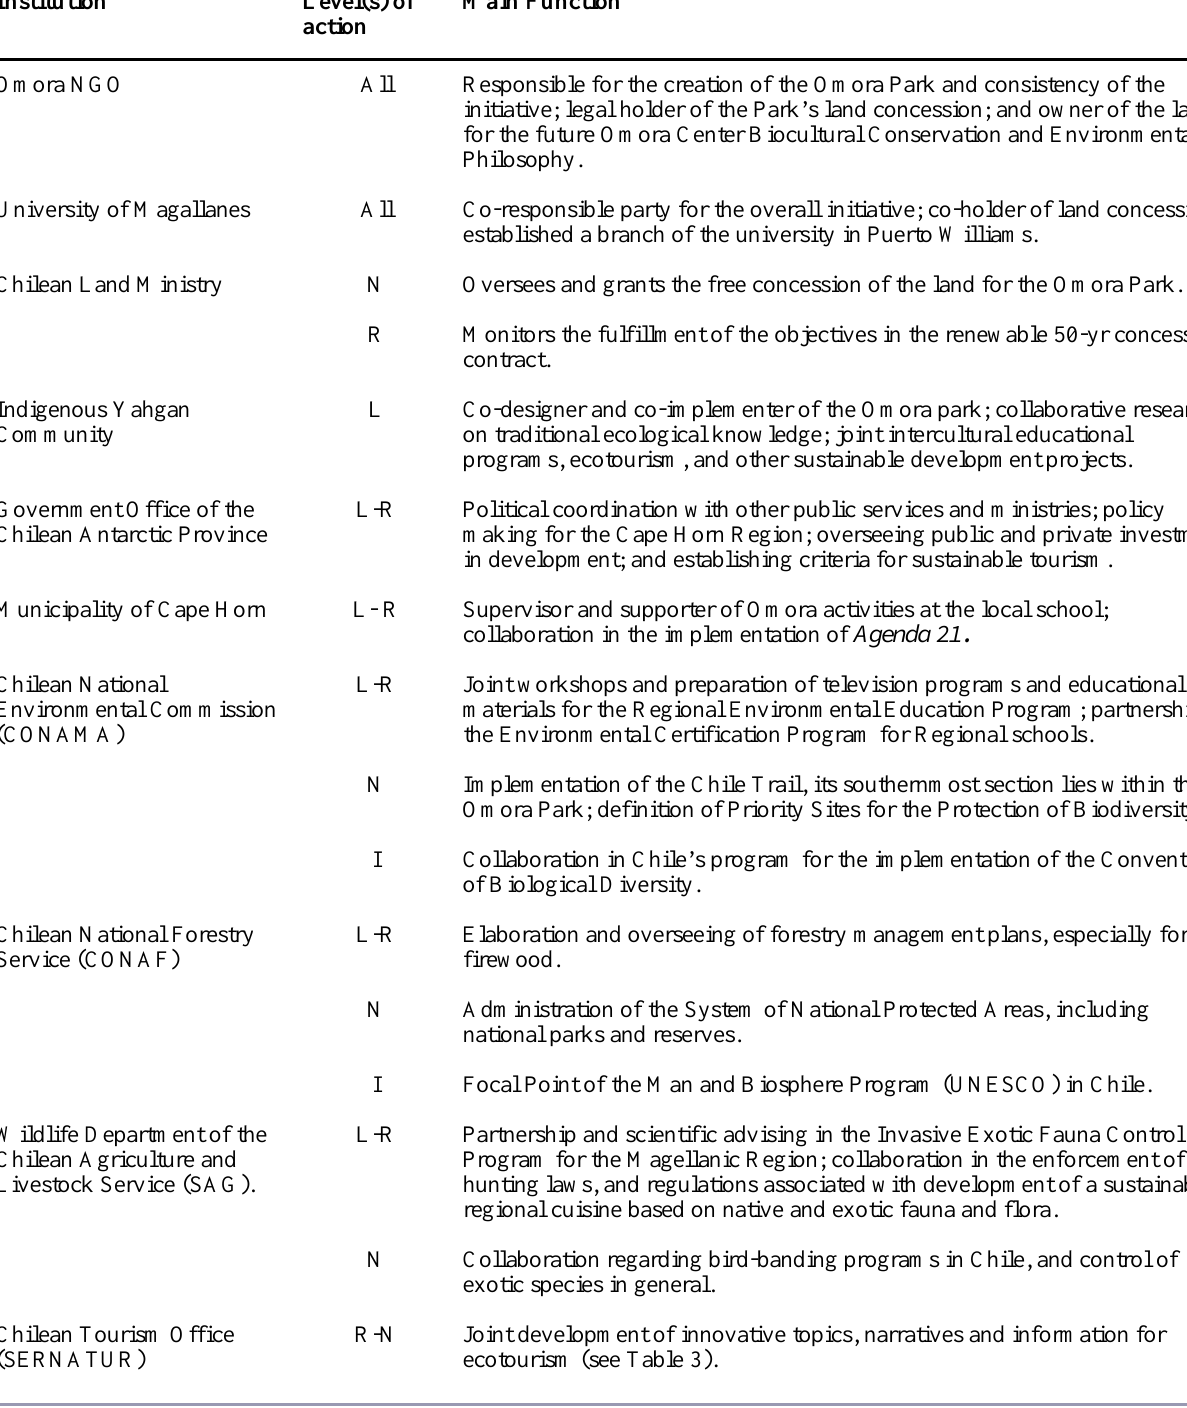
Table 2. Core institutions involved in the Omora initiative at local (L) regional (R), national (N), and/or international (I) levels. The main functions of each institution are pointed out for each